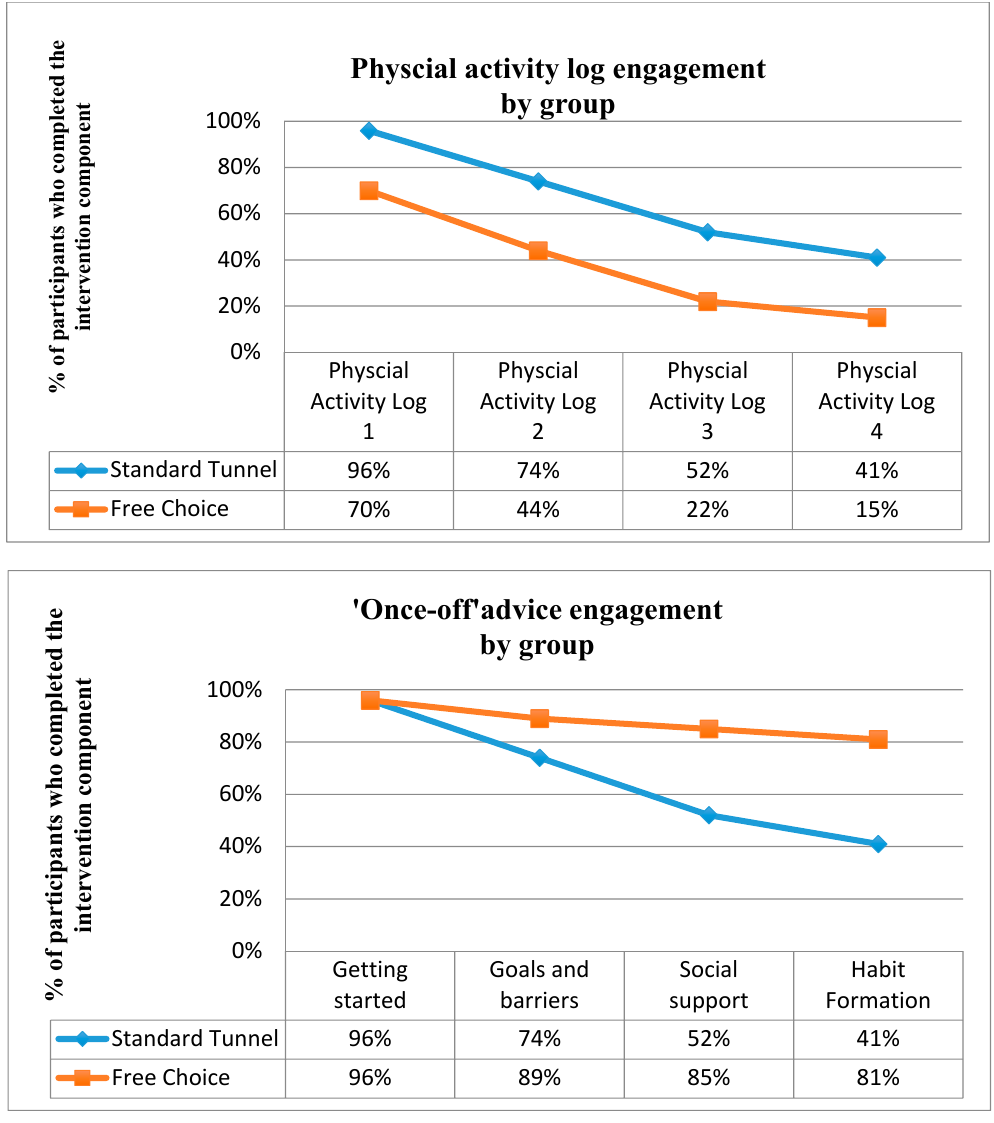
Figure 5. Website module engagement by group.